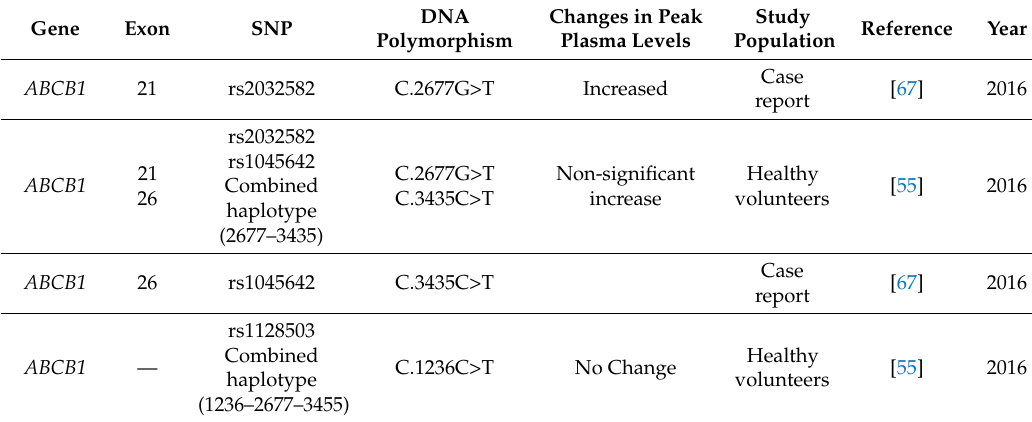
Table 2. Common genetic variants associated with pharmacodynamics and pharmacokinetics of